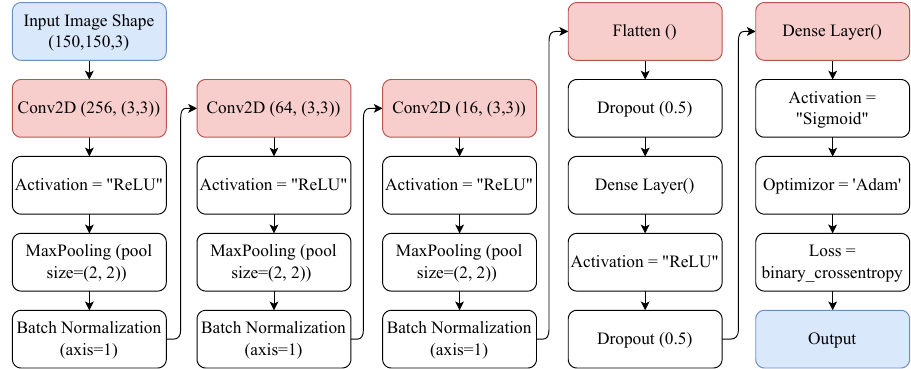
Figure 3. Architecture of CNN model used in this